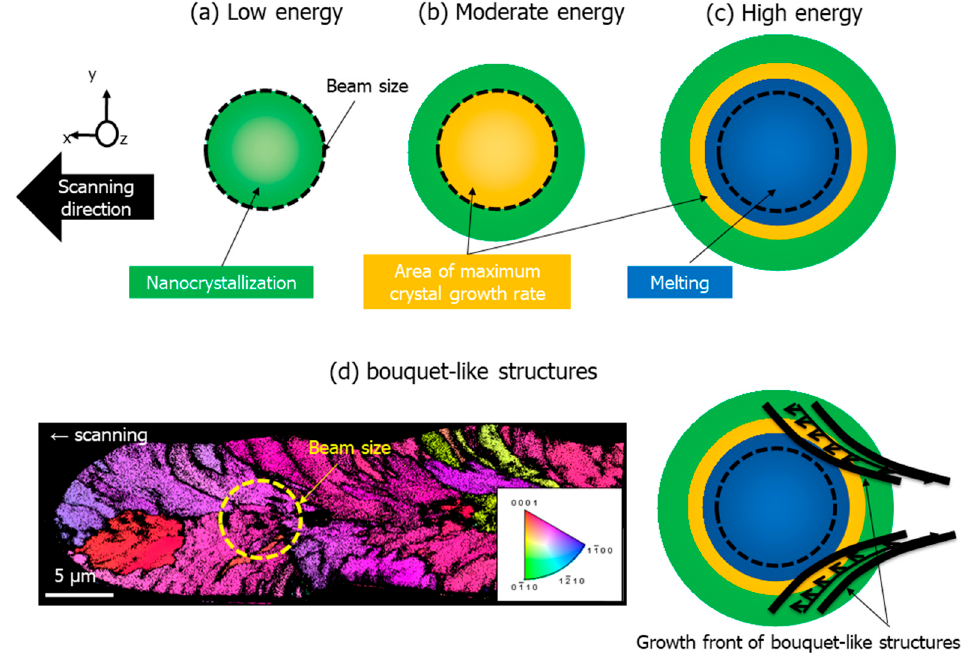
Figure 1. ( a ) A regime of nanogratings’ crystallization, with orientation controlled by light polarization; ( b ) a regime with a maximized growth rate at the center; ( c ) a regime where part of the irradiated region is melted; ( d ) the growth rate upon scanning yields to the formation of bouquet-like structures (adapted from [14]). Additional details on experimental work: fs laser-induced nanostructures (LiNbO 3 seen by EBSD coded, on the base of R3c space group, in the direction of laser propagation) in 32.5%Li 2 O-27.5%Nb 2 O 5 -40%SiO 2 (mol%) glass, laser wavelength 1030 nm, pulse duration 300 fs, pulse frequency 500 kHz, scanning speed 5 µm/s, and focus 450 µm below the surface with a pulse energy at 1.8 µJ. The color code indicates the crystal direction along writing laser propagation direction. Dark regions are opened from the center to the periphery as with a bouquet oriented towards the writing direction. The laser beam size (yellow circle) is one-third of the written line width.